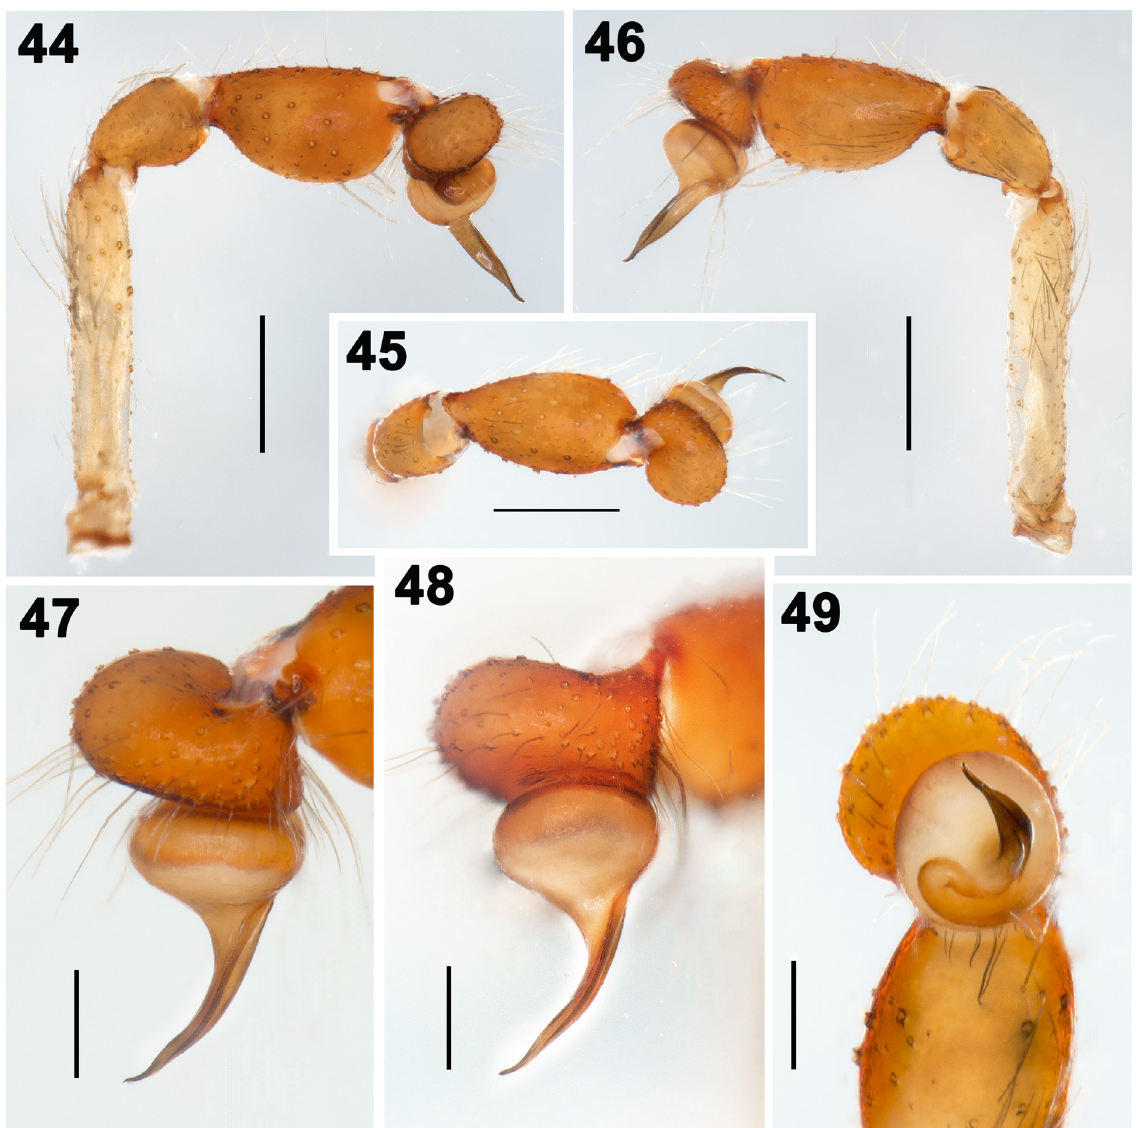
Figs 44–49. Loxosceles jaca Gertsch & Ennik, 1983. 44–46 . Left palp, prolateral, dorsal and retrolateral views respectively. 47–49 . Detail of the bulb and the embolus: retrolateral, dorsal and apical views, respectively. Scale bars: 44–46 = 0.5 mm; 47–49 = 0.2